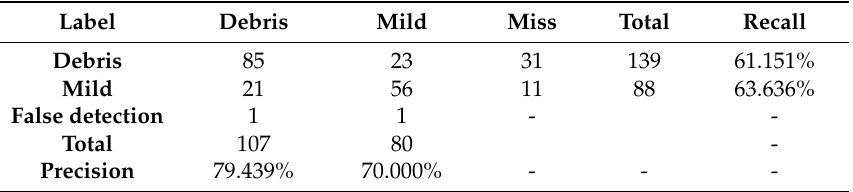
Table 5. The results of the data augmentation method in the test dataset.